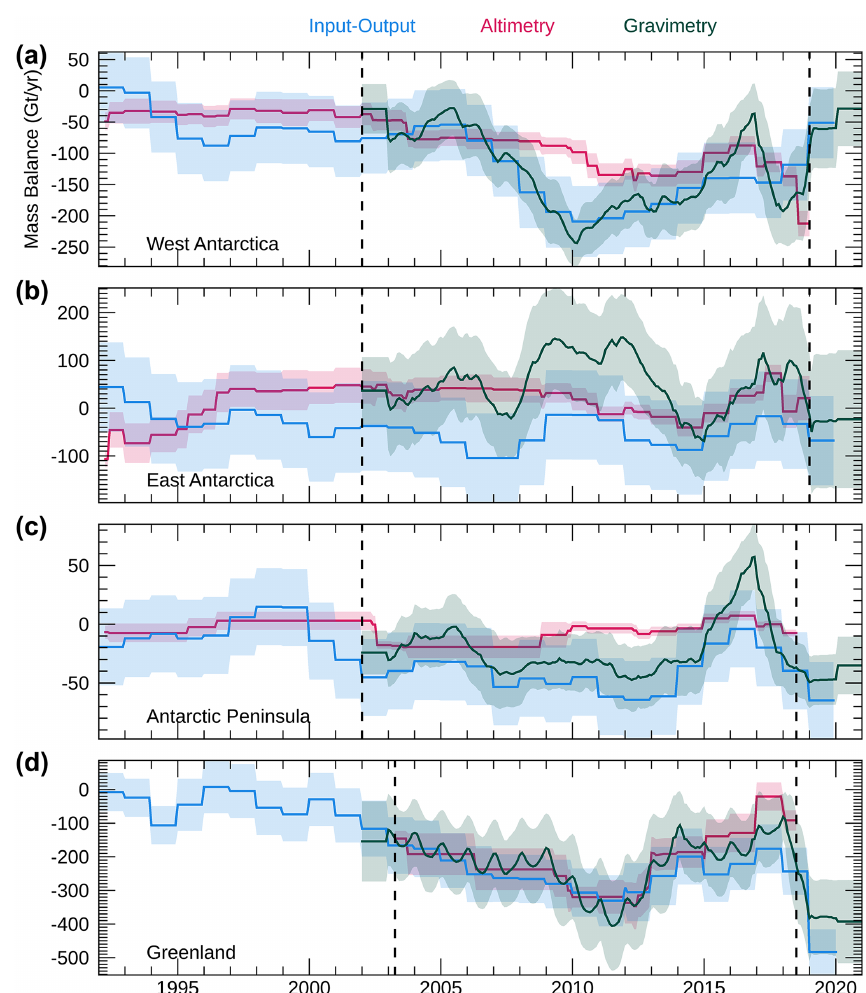
Figure A1. Mass balance time series from the aggregated altimetry, gravimetry, and input–output method over (a) WAIS, (b) EAIS, (c) APIS, and (d) GrIS. The vertical dashed lines mark the overlap period of the three time series. The aggregated time series and corresponding uncertainties are calculated following the methods described in Sect. 3 (ii).